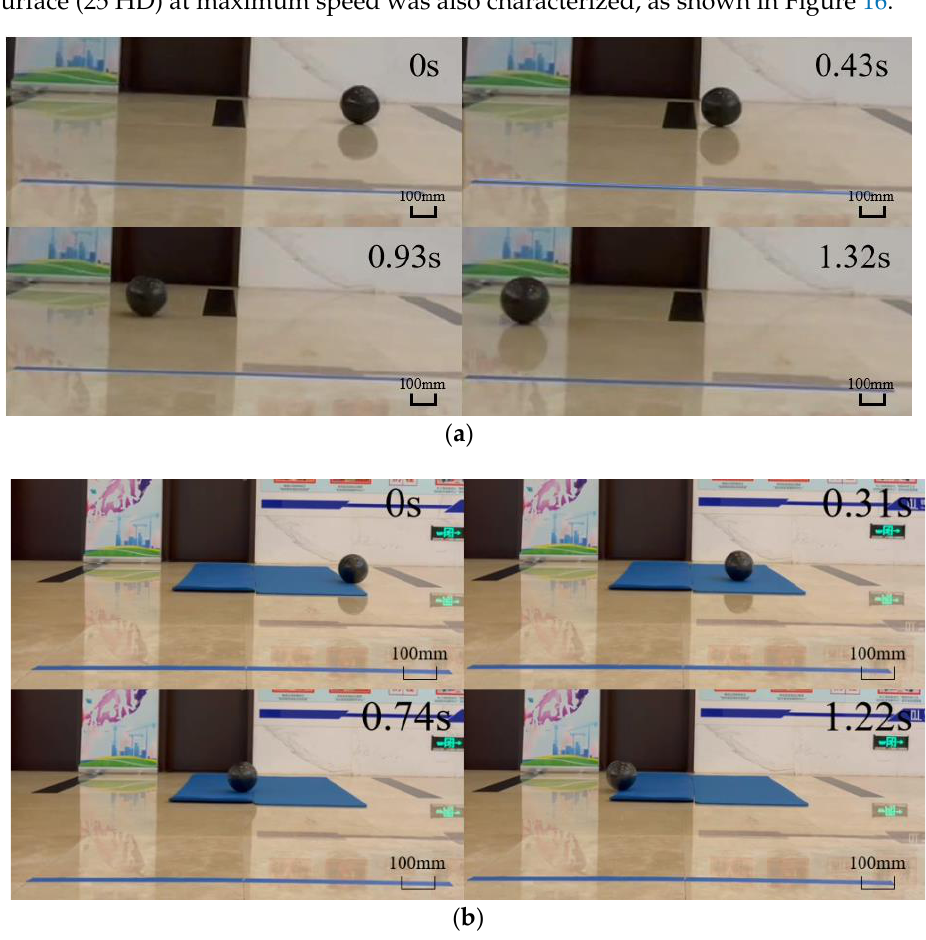
Figure 16. Rolling motion of the robot: ( a ) hard and flat surface (90 HA); ( b ) loose surface (25 HD). At full power, the maximum rolling speed of the robot was about 1229.5 mm/s, which decreased to 1147.5 mm/s when passing over loose road surfaces.